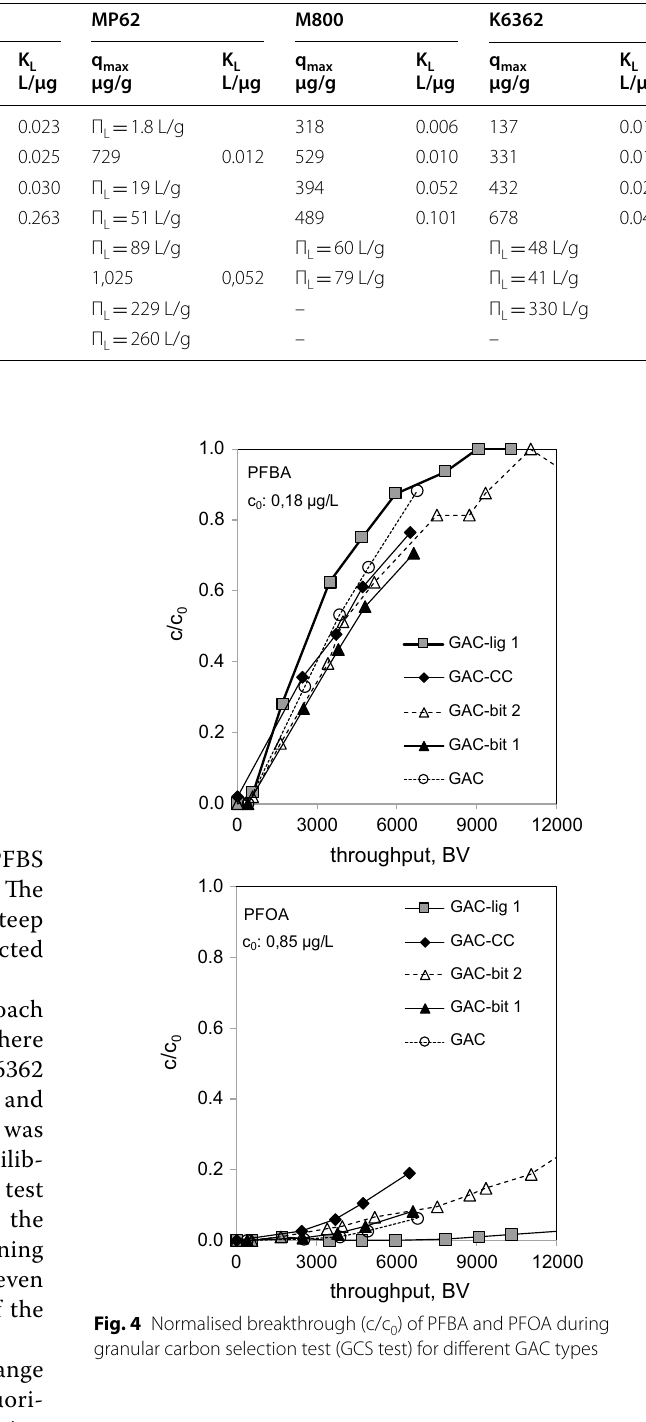
Selection of GAC The granular carbon selection test (GCS test) was devel- oped to compare the adsorption capacities of different types of GAC [9] in order to select the optimal GAC.